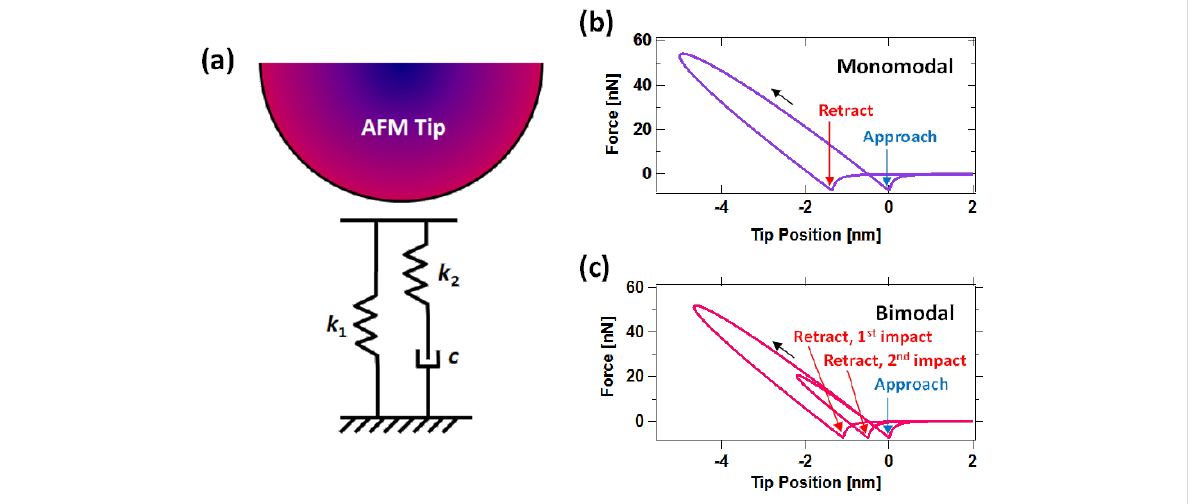
Figure 1: (a) Schematic of AFM tip interacting with the standard linear solid model; (b) example of force curve for monomodal AFM; (c) example of force curve for bimodal AFM, showing a double impact. The blue arrows indicate in each case the position where the tip first reaches the sample, and the red arrows indicate the position where the tip leaves the sample. Van der Waals forces have been included in the attractive (noncontact)